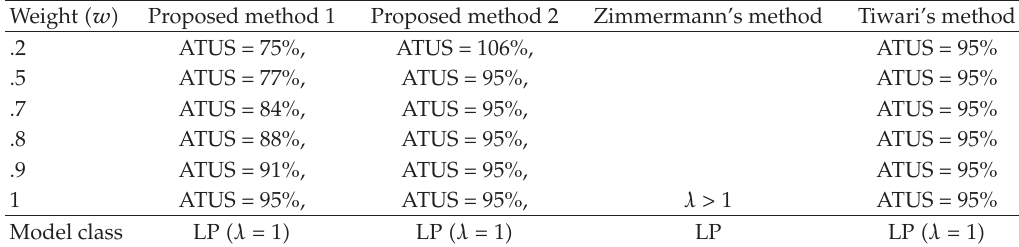
Table 6: Solution of the fuzzy linear goal programming problem by applying di ff erent methods. Weight (cid:2) w